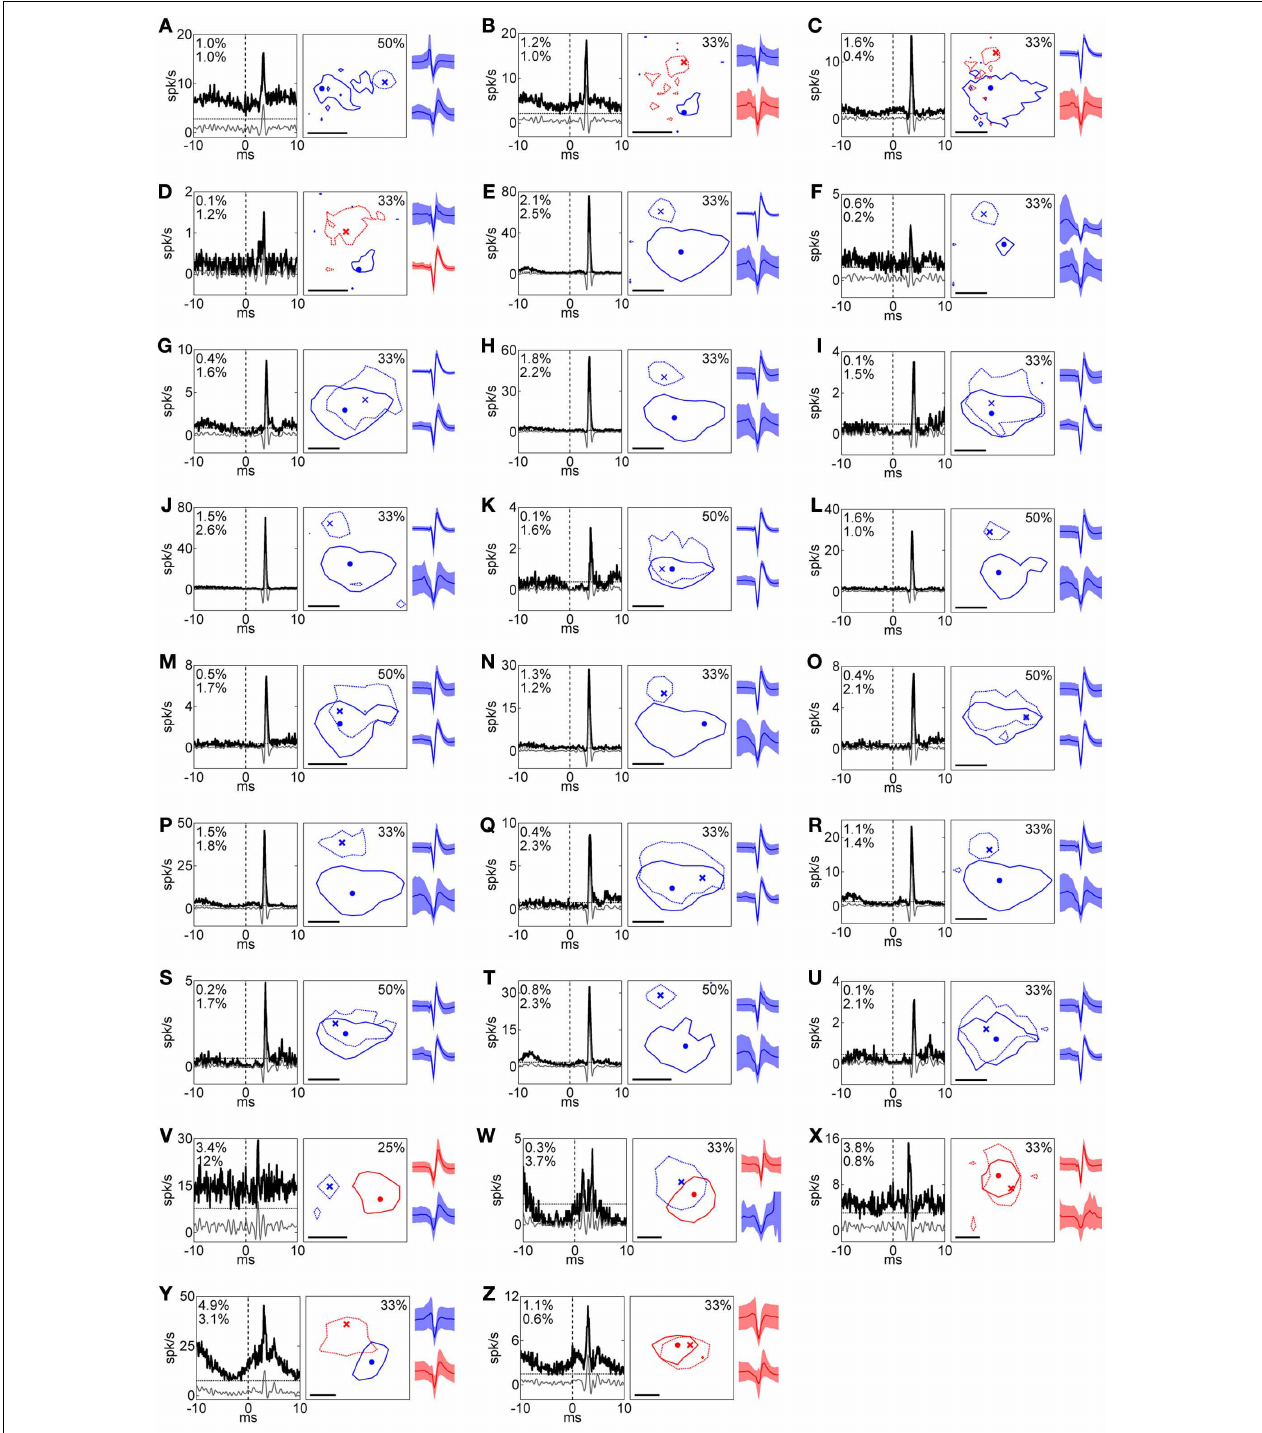
FIGURE 2 | Summary of RFs and corresponding XC s for all pairs. (A)–(Z) Left, middle, and right columns indicate XC , RF, and spike shape, respectively. In the XC columns, black solid, gray solid, and horizontal dotted lines indicate raw XC , filtered XC , and threshold (mean + 5 SD ), respectively, and numbers read efficacy (upper) and contribution (lower). In RF columns, solid and dotted lines indicate the RFs of the RGC and the LGN neuron, respectively. Numbers read the response levels of the contour lines for the both of units. Dot and cross symbols indicate the maximum